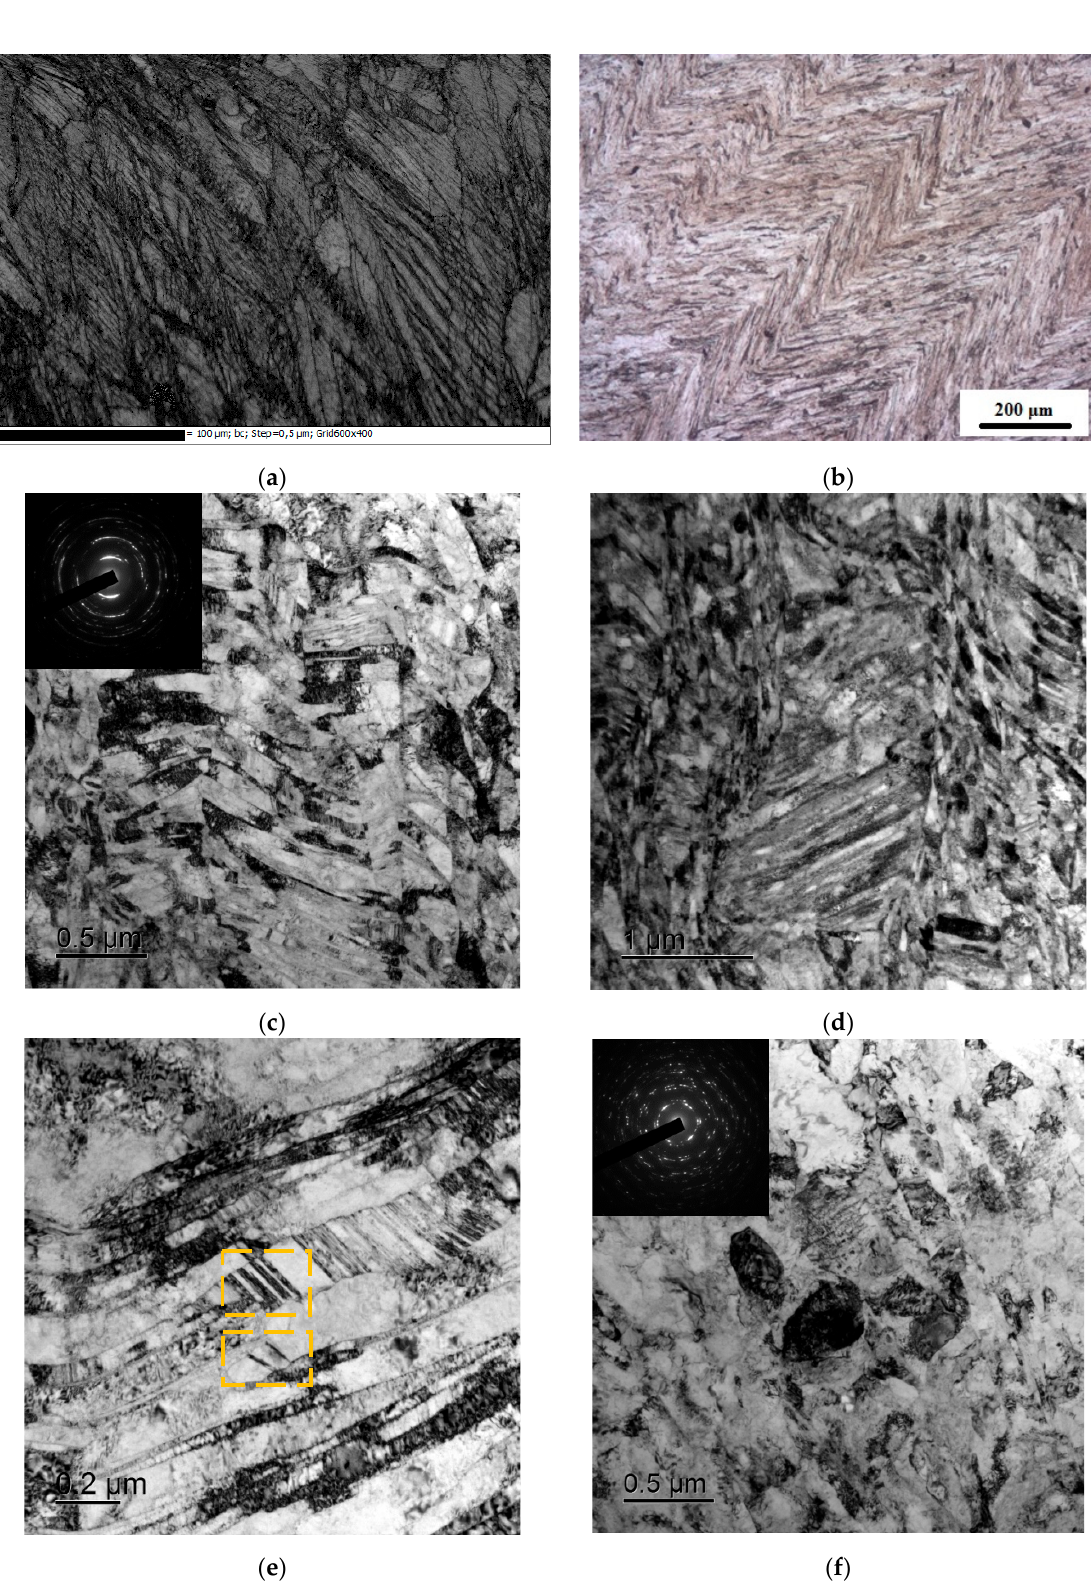
Figure 4. Macrostructure ( a , b ) and microstructure ( c – f ) of UFG steel specimens: ( a , b ) macrostructure of steel specimens after the first ECAP cycle at 150 ◦ C ( a ) and 450 ◦ C ( b ); TEM-microphotographs and electron diffraction patterns of a steel microstructure after ECAP (N = 4) at 150 ◦ C ( c – e ) and 450 ◦ C ( f ). Nanotwins in ( f ) are marked with dash lines. ( b ) shows microscopic shear bands.